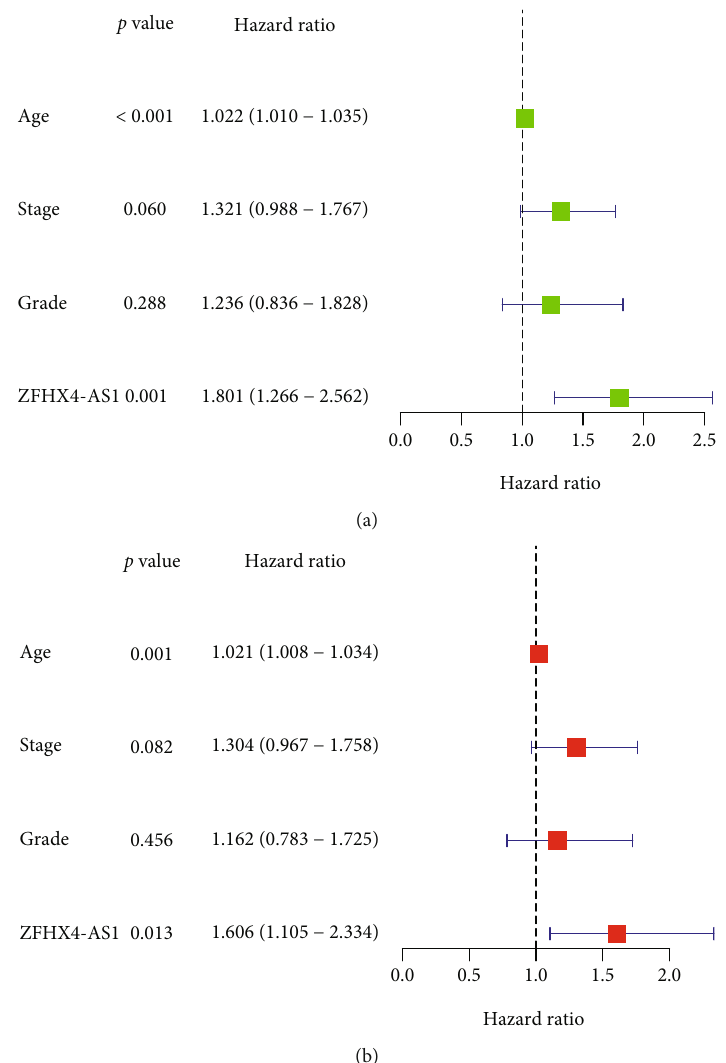
Figure 2: (a) Univariate and (b) multivariate assays were applied to further explore the prognostic value of ZFHX4-AS1 in OC